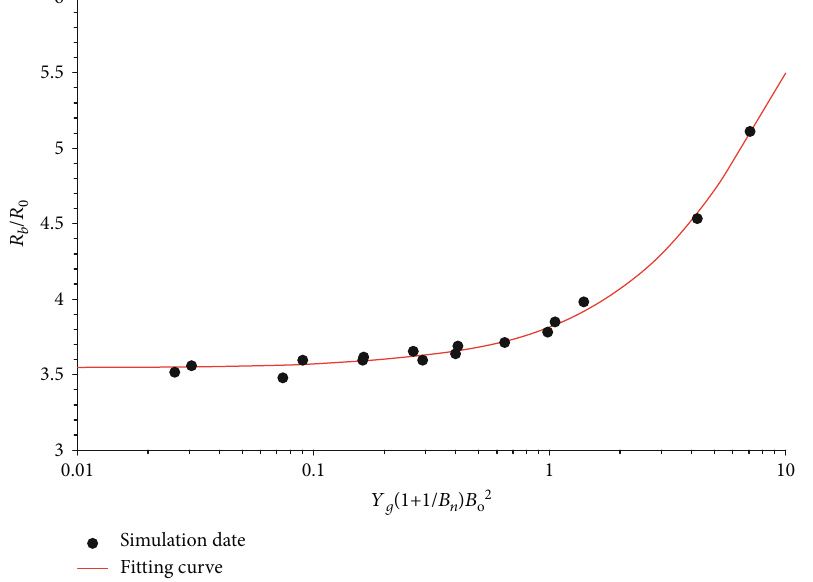
Figure 15: Errors of dimensionless equivalent radius of detached